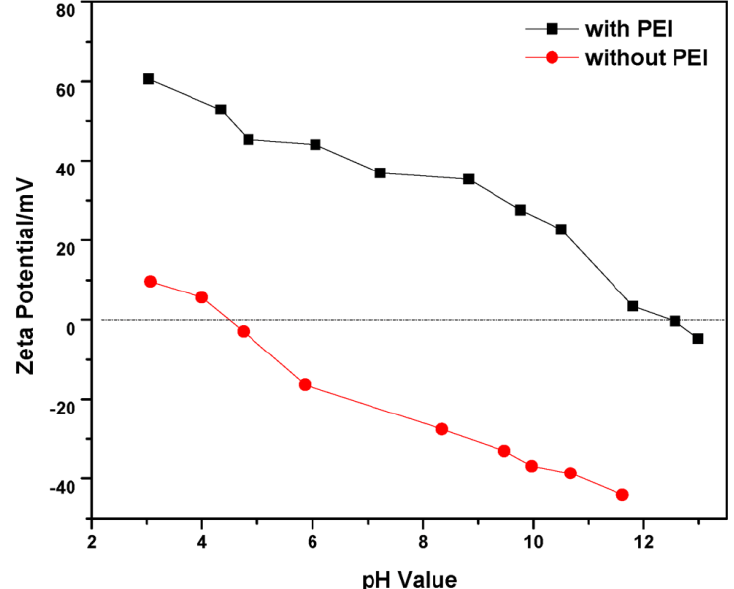
Figure 1. Zeta potential of ZrB suspensions with and without presence of polyethyleneimine 2